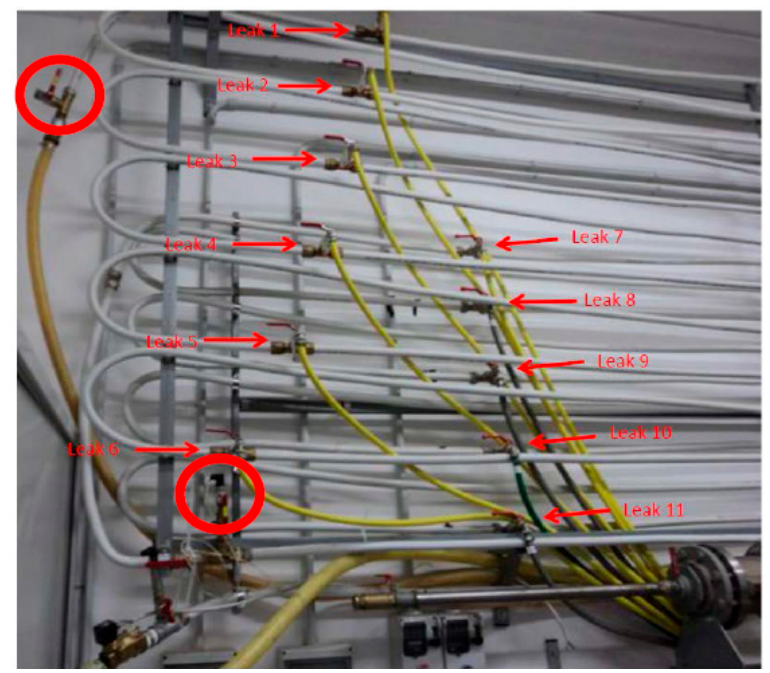
Figure 11. Leaks locations on the experimental pipeline with circled sensors.